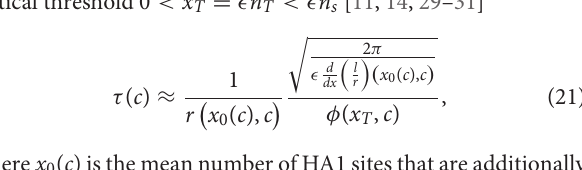
where x 0 ( c ) is the mean number of HA1 sites that are additionally protonated for a concentration c > 10 − 7 mol.L − 1 (Equation 16). The function φ ( x , c ) is given by